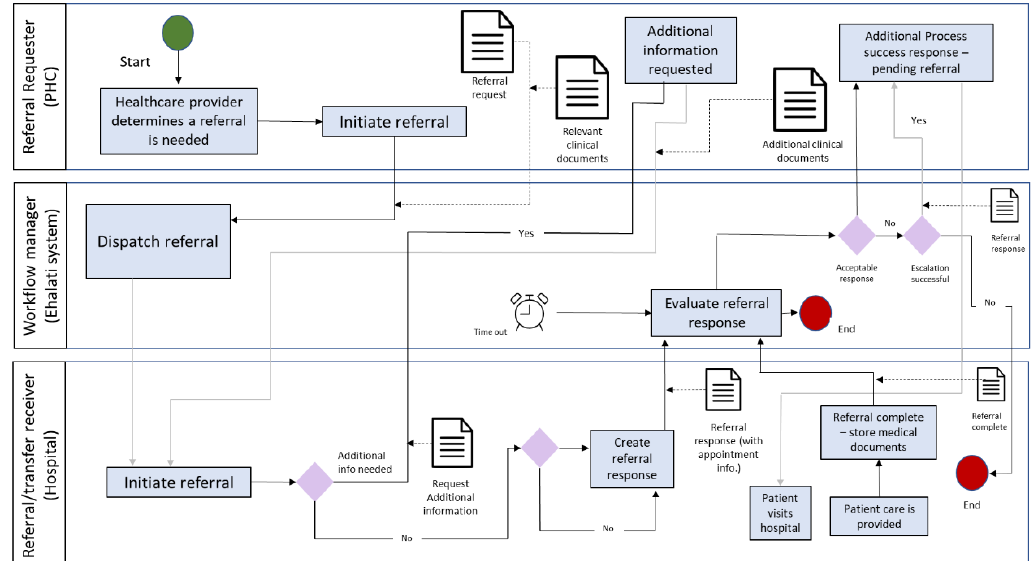
Figure 1. E-referrals process workflow